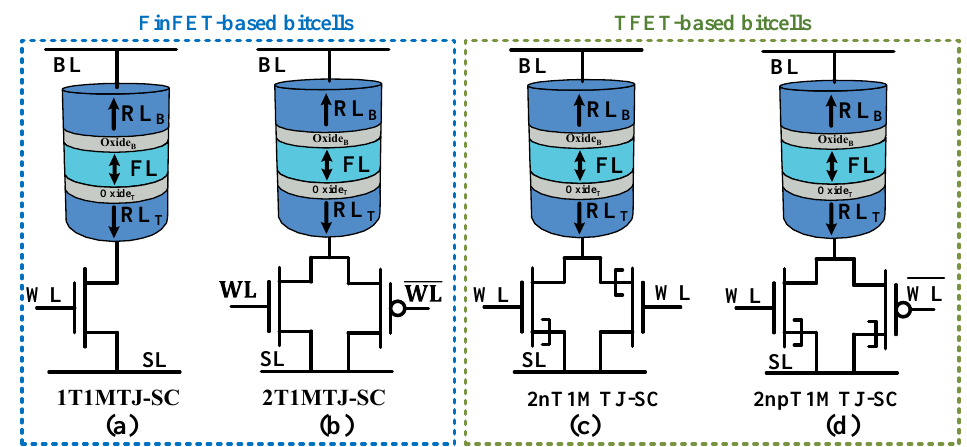
Figure 4. FinFET-based bitcells: ( a ) one NMOS-one MTJ in standard connection (SC), 1T1MTJ-SC, ( b ) complementary NMOS and PMOS transistors with one MTJ in SC (2T1MTJ-SC). TFET-based bitcells: ( c ) two n -type TFETs-one MTJ in SC (2nT1MTJ-SC), ( d ) complementary n - and p -type TFETs with one MTJ in SC (2npT1MTJ-SC).